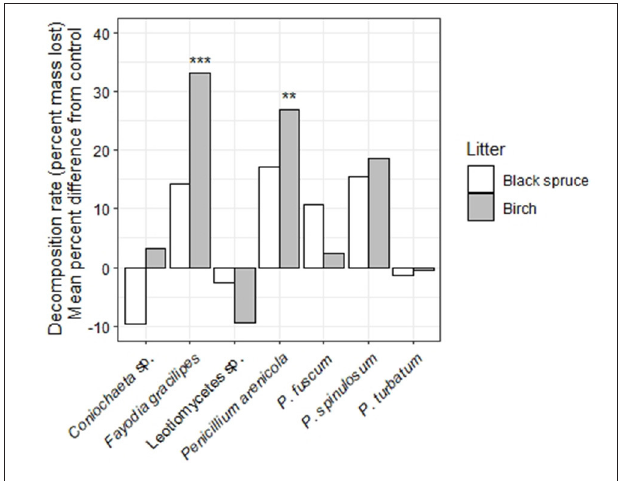
FIGURE 3 | Saprotrophic activity of seven heat-resistant fungal taxa, as measured by decomposition rates measured as mass lost of black spruce (white bars) and birch (gray bars) litter over 10 wks incubation in controlled conditions. Results are presented as the mean percent difference for each fungal treatment from the uninoculated control treatment, from 999 bootstrap samples. Values above zero indicate greater decomposition in inoculated samples relative to the control treatment. Asterisks indicate significant effects of inoculation relative to the control treatment based from linear models ( ** P < 0.01; *** P < 0.001; Table S3 ).